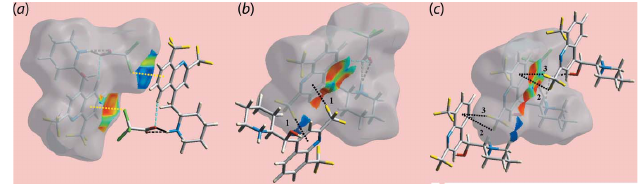
Figure 6 Three views of Hirshfeld surface of (I) mapped over the shape-index property highlighting ( a ) C—Cl (cid:2)(cid:2)(cid:2) (cid:2) / (cid:2) (cid:2)(cid:2)(cid:2) Cl—C contacts through yellow dotted lines, ( b ) and ( c ) C—F (cid:2)(cid:2)(cid:2) (cid:2) / (cid:2) (cid:2)(cid:2)(cid:2) F—C contacts with through black dotted lines. The ‘1 0 , ‘2 0 and ‘3 0 refer to the F1—F3 atoms,